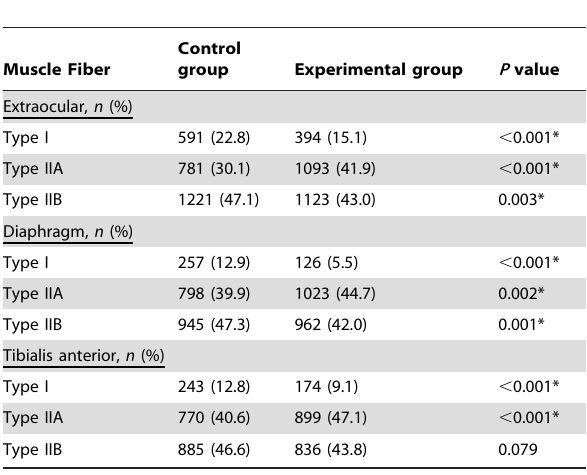
Figure 1. A. Ocular symptoms in PTMG rats. B. Wet weight of the extraocular muscles (EOM) in the control group and experiment group. C. Level of creatine kinase (CK) in the serum determined by ELISA. *Significant ( P , 0.05) difference between the control and experimental groups determined by independent two-sample t test. doi:10.1371/journal.pone.0055611.g001 Table 1. Comparison of the proportion of three types of muscle fibers in muscles in the two